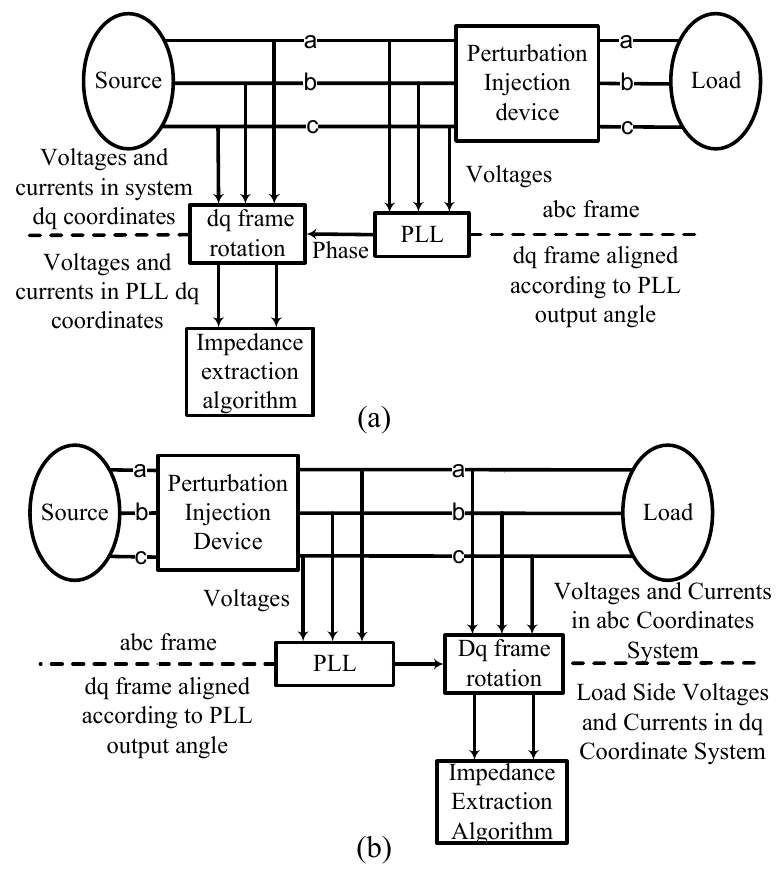
Figure 8. Impedance measurement setup in dq coordinates for ( a ) Source Side ( b ) Load